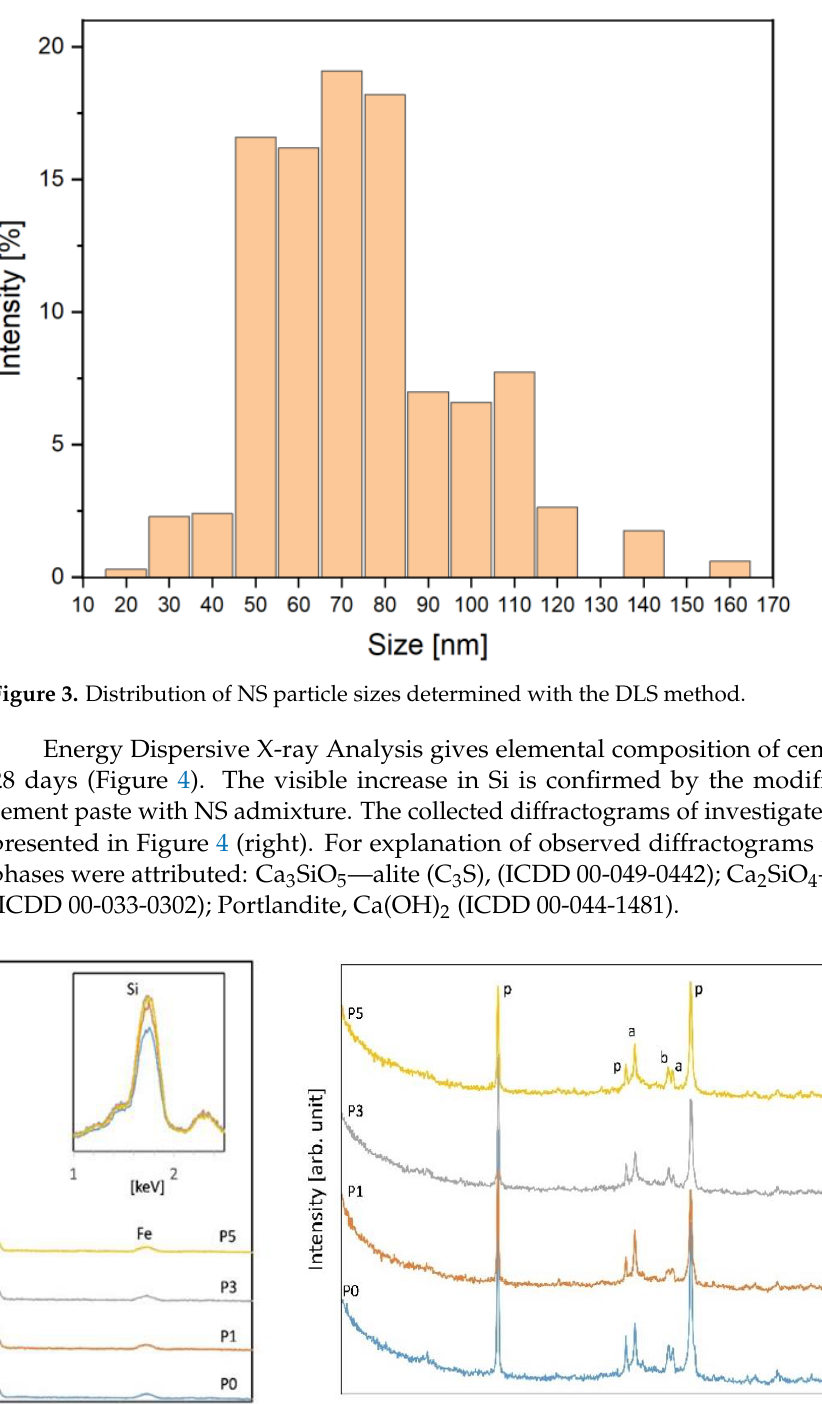
( b ) Figure 4. EDS spectra ( a ) and XRD spectra ( b ) of specimens after 28 days of curing. 3.2. Thermogravimetric Analysis In Figures 5 – 8, the results of thermogravimetric measurements are shown. The cor- responding mass spectroscopy plots of H 2 O and CO 2 within the time are shown in Figures